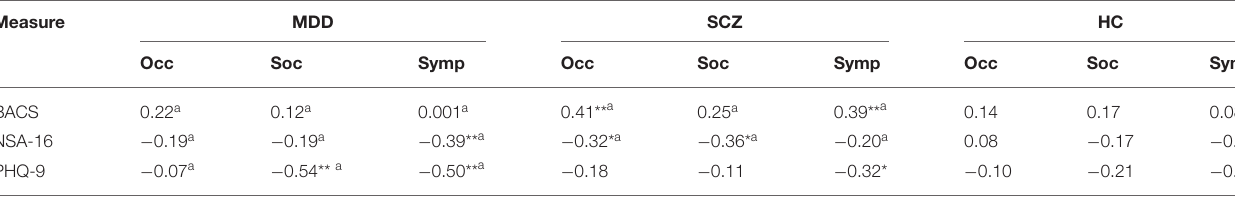
TABLE 2 | Association between MIRECC-GAF, BACS composite, NSA-16 total and PHQ-9 total across groups. Measure MDD SCZ HC Occ Soc Symp Soc Soc Symp BACS